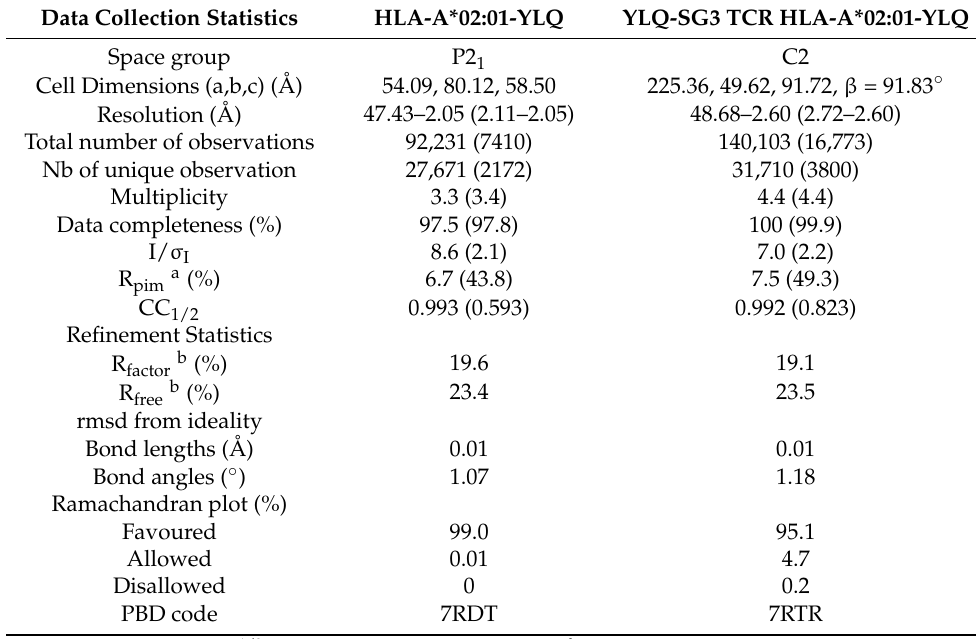
Table 3. Data collection and refinement statistics.